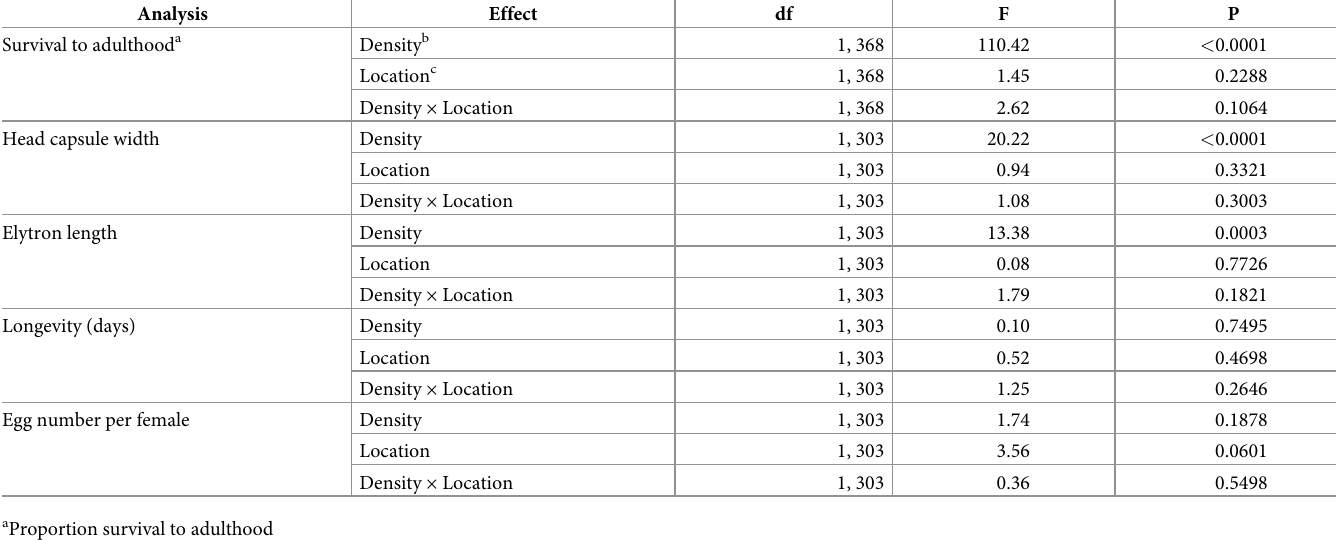
Table 1. Analyses of variance for life-history characteristics from the voluntary flight experiment.